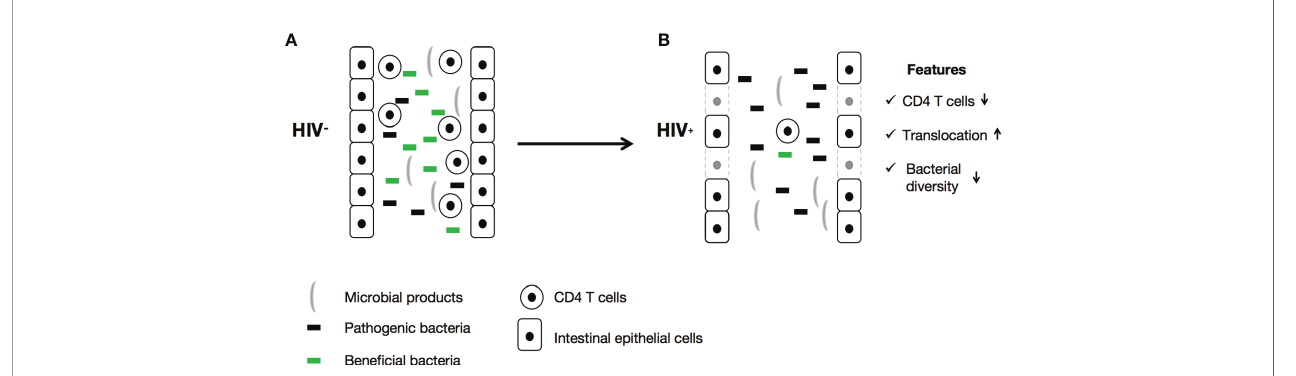
FIGURE 1 | HIV is responsible for gut microbiota dysbiosis and the onset of leaky